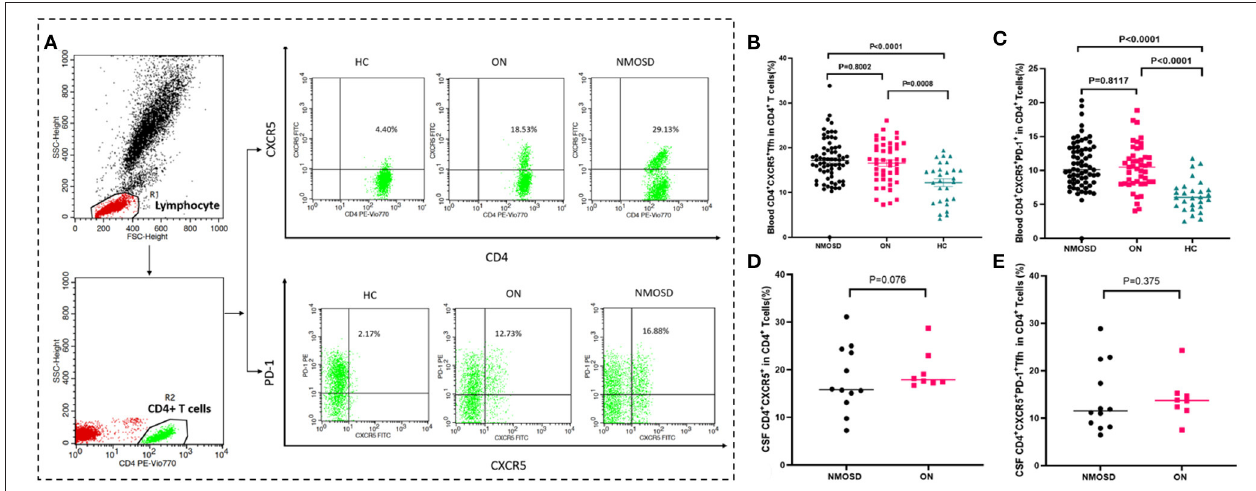
FIGURE 1 | Comparison of Tfh cell percentage in CD4 + cells between HC, ON, and NMOSD groups. (A) The strategy for gating CD4 + CXCR5 + and CD4 + CXCR5 + PD-1 + cells from CD4 + cells. CD4 + cells were first gated from the peripheral blood lymphocyte. The CD4 + CXCR5 + and CD4 + CXCR5 + PD-1 cells were then gated from the CD4 + population. The data above the outlined area were the percentages of Tfh cells in CD4 + cells in HC /ON/NMOSD groups. (B,C) Comparison of percentages of blood CD4 + CXCR5 + and CD4 + CXCR5 + PD-1 cells in CD4 + T cells between NMOSD, ON, and HC groups. (D,E) Comparison of